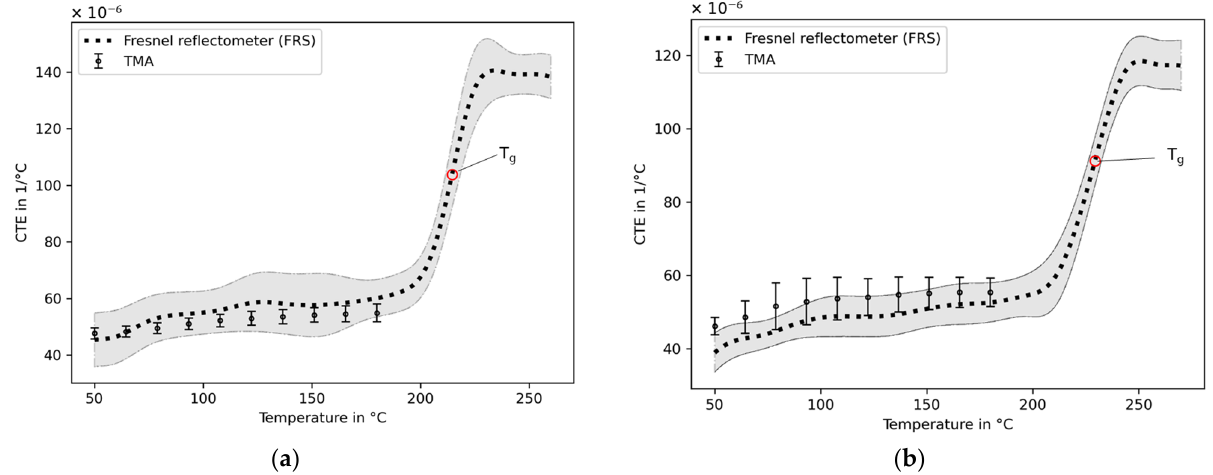
Figure 6. Temperature-dependent CTEs derived from the local derivatives of the refractive index measurements and TMA results of PEI ( a ) and PES ( b ), including the glass transition temperature Tg calculated from the inflection points.